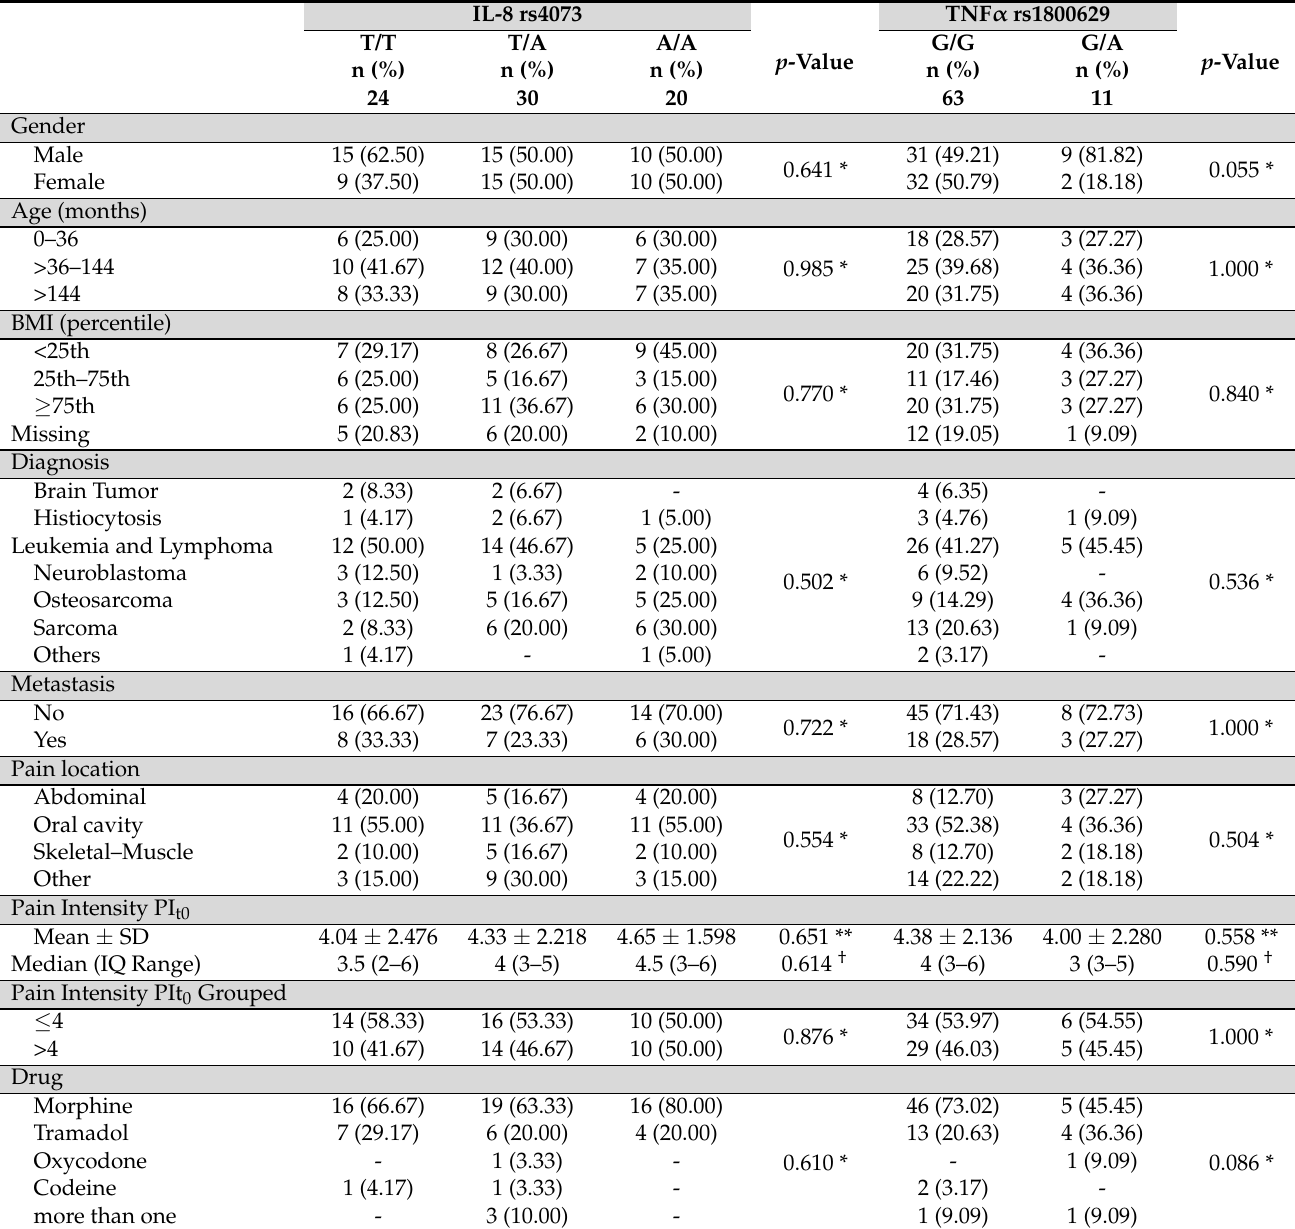
Table 3. Characteristics of the 74 subjects included in the STOP Pain Project and efficacy and safety parameters according to IL 8 T251A and TNF α G308A polymorphisms.